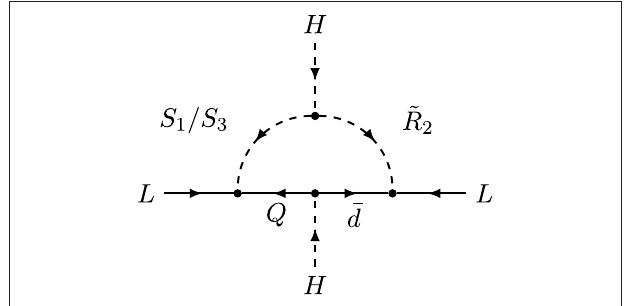
FIGURE 21 | 1-loop neutrino masses generated via leptoquark mixing.